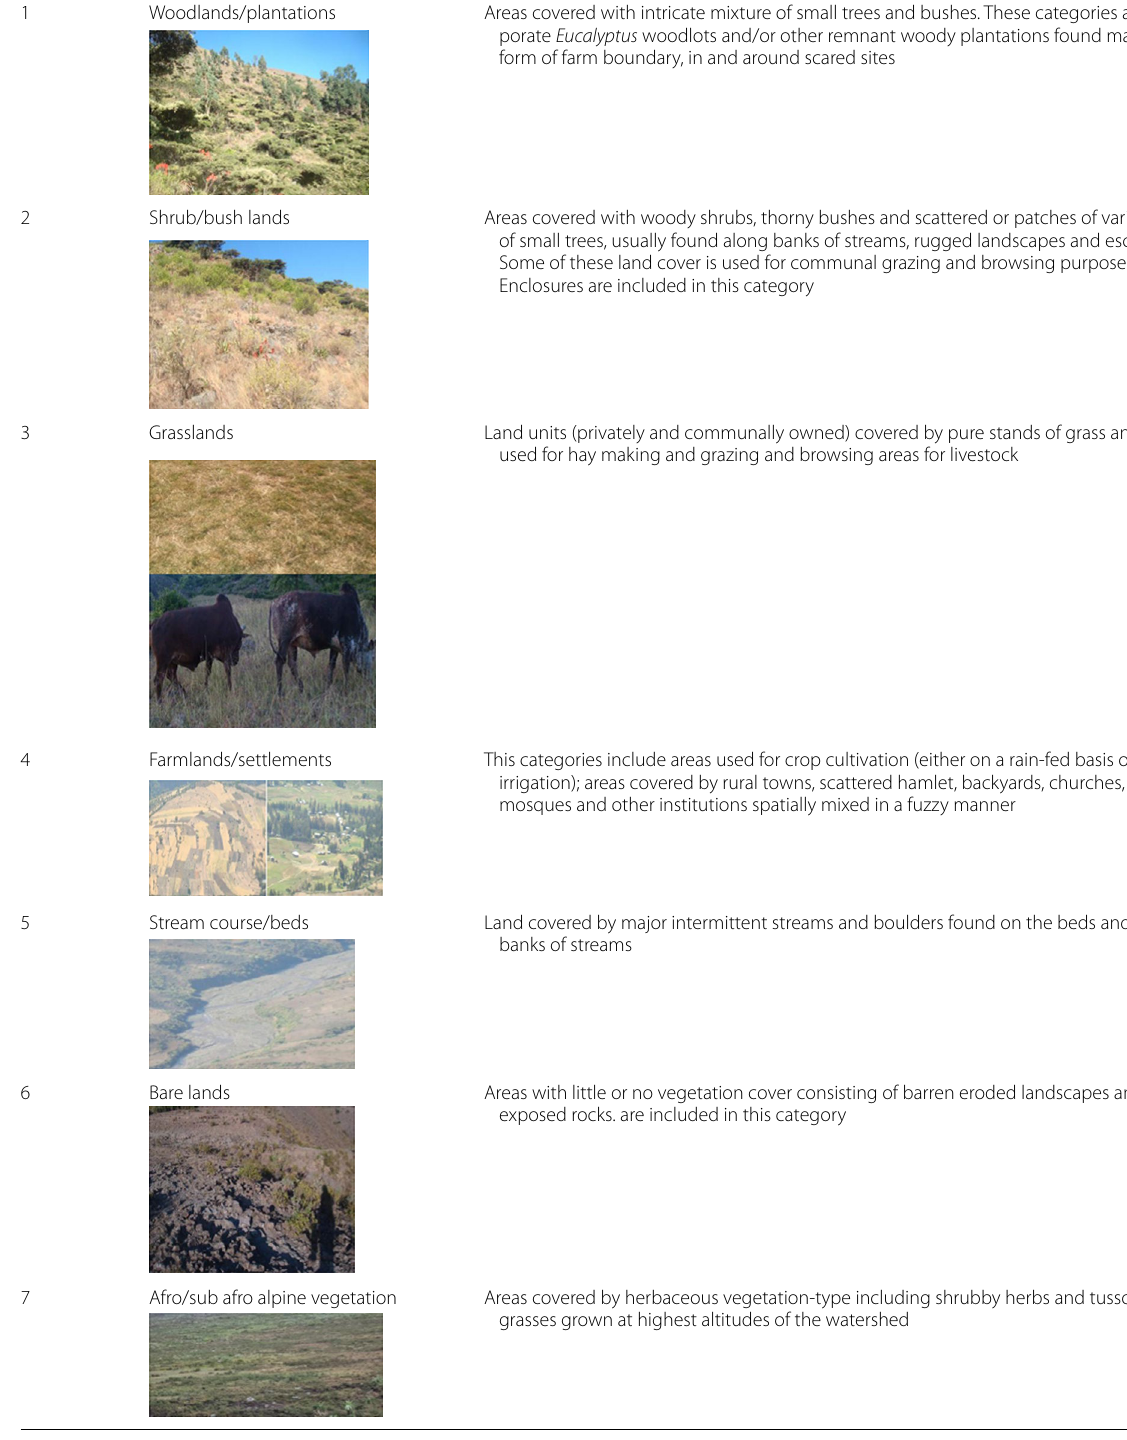
Table 2 Description of examples of LULC classes identified in Gedalas watershed S/N Land use/cover classes